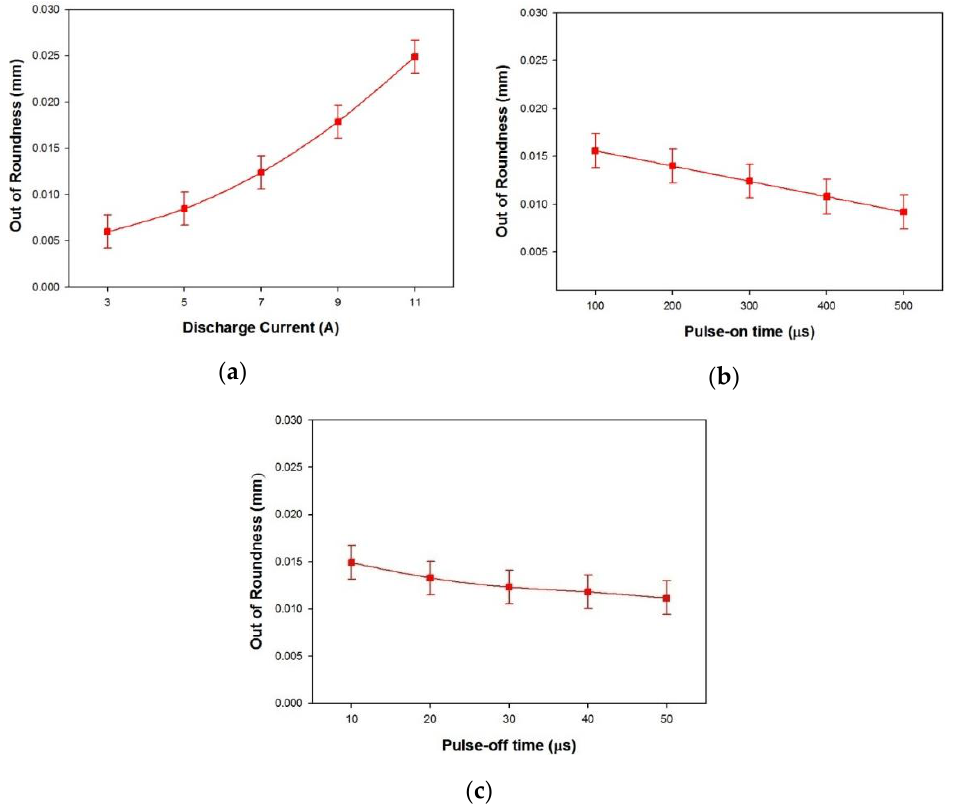
Figure 5. Out-of-roundness variation with ( a ) I p , ( b ) T on , ( c ) T